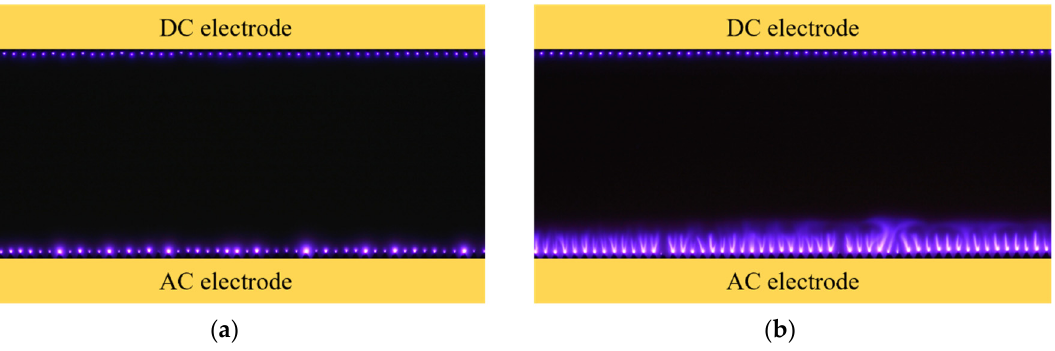
Figure 18. Discharge photographs in the case where a voltage of 10 kV pp at 8 kHz was applied to the AC electrode, and a voltage of 14 kV was applied to the DC electrode, in the ( a ) CD-PA and ( b ) TED- PA.